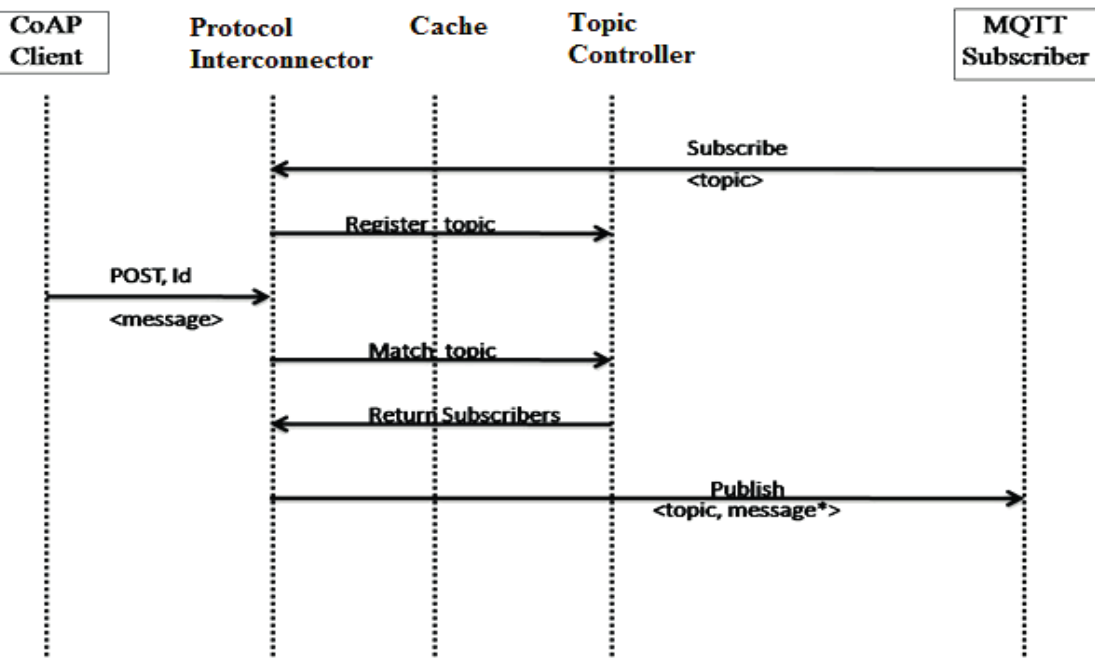
Fig. 2. Communication between CoAP client and MQTT